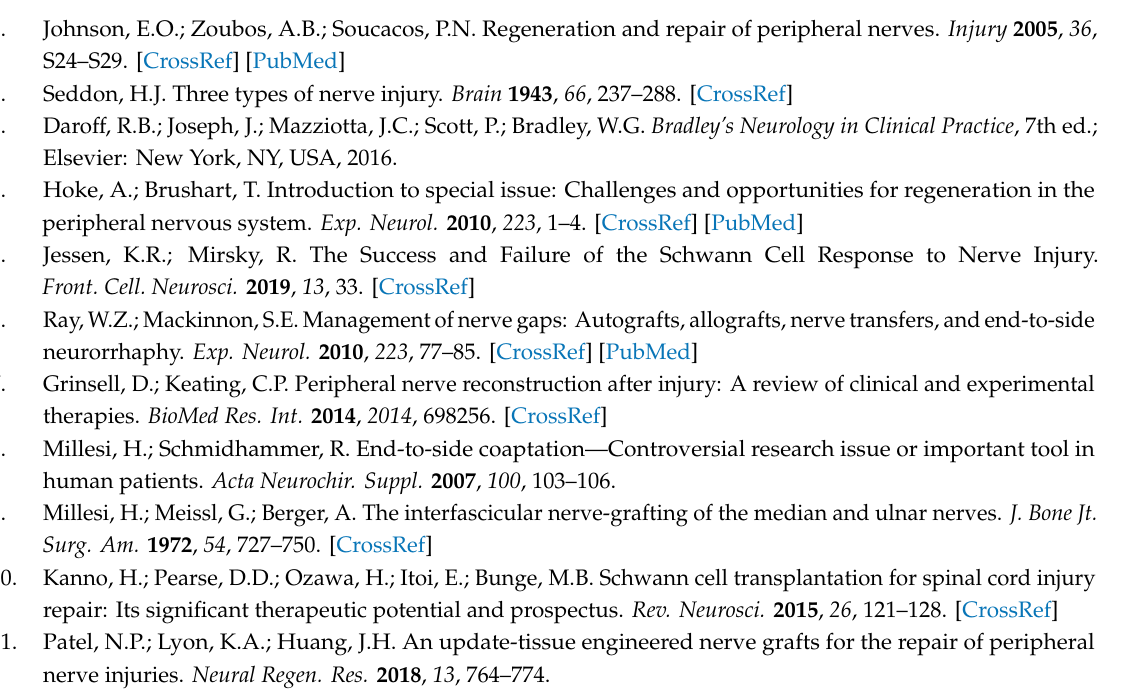
Figure S1: Characterisation of rADSCs and rADSC-EVs., Table S1: Antibodies, Table S2: Primer sequences used for